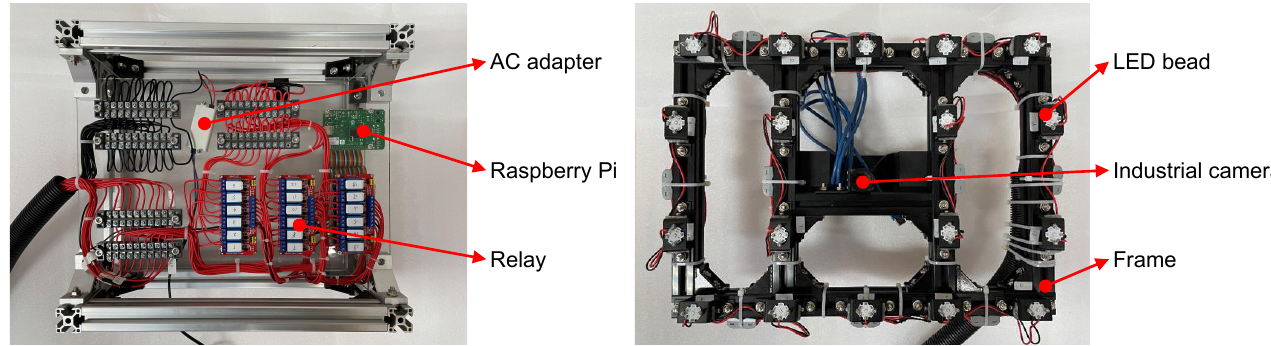
Figure 3. Diagram of the PSDCE and its control cabinet. The image on the left is a control cabinet. We used the Raspberry Pi to control the LED. As the IO port voltage of the Raspberry Pi cannot meet the needs of all LED beads, we used an AC adapter in conjunction with a relay to power LED. The image on the right is the PSDCE. The frame has been blackened to prevent reflective interference. The LED beads are mounted on the frame and the industrial camera is mounted at the centre of the